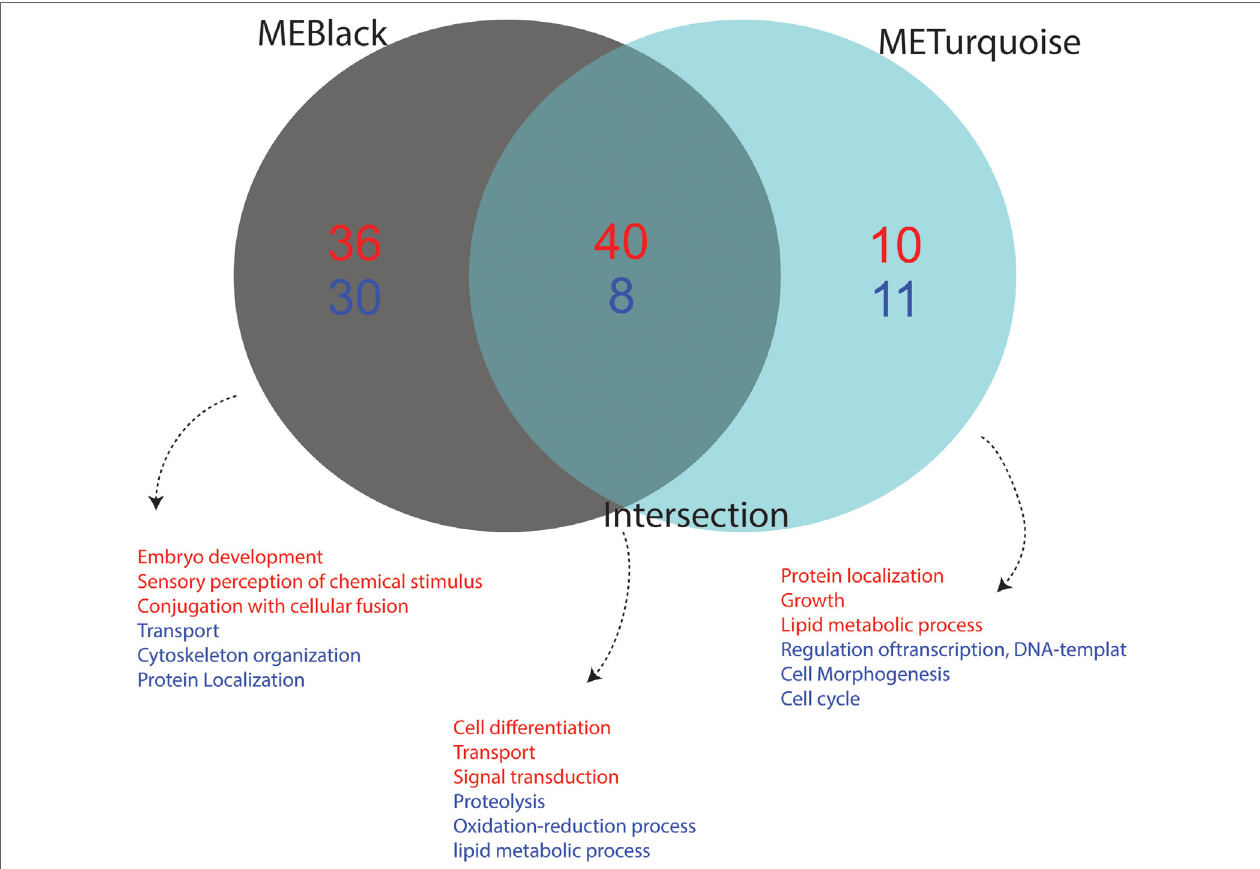
FigUre 6 | Functional annotation of up- and downregulated genes from each condition. The Gene Ontology (GO) annotation of differentially expressed genes from each module is shown. Terms in red represent upregulated functions while those in blue represent downregulated functions. Association of GO terms to genes was performed using VectorBase. The number of downregulated genes is depicted in blue and upregulated genes in red. The intersection represents the common genes between the black and turquoise modules, which corresponds to a viral-infection specific